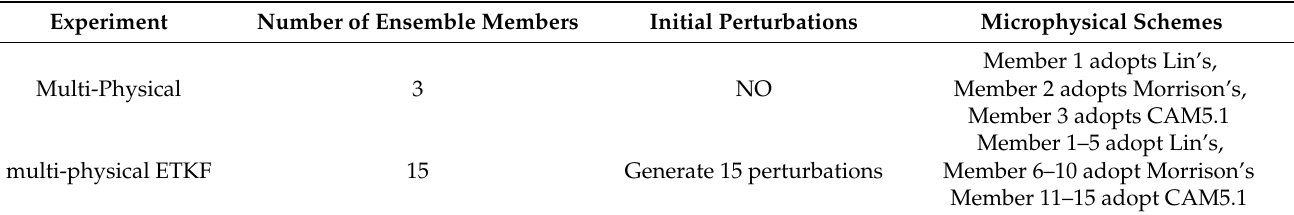
Table 1. Experiment design for two ensemble